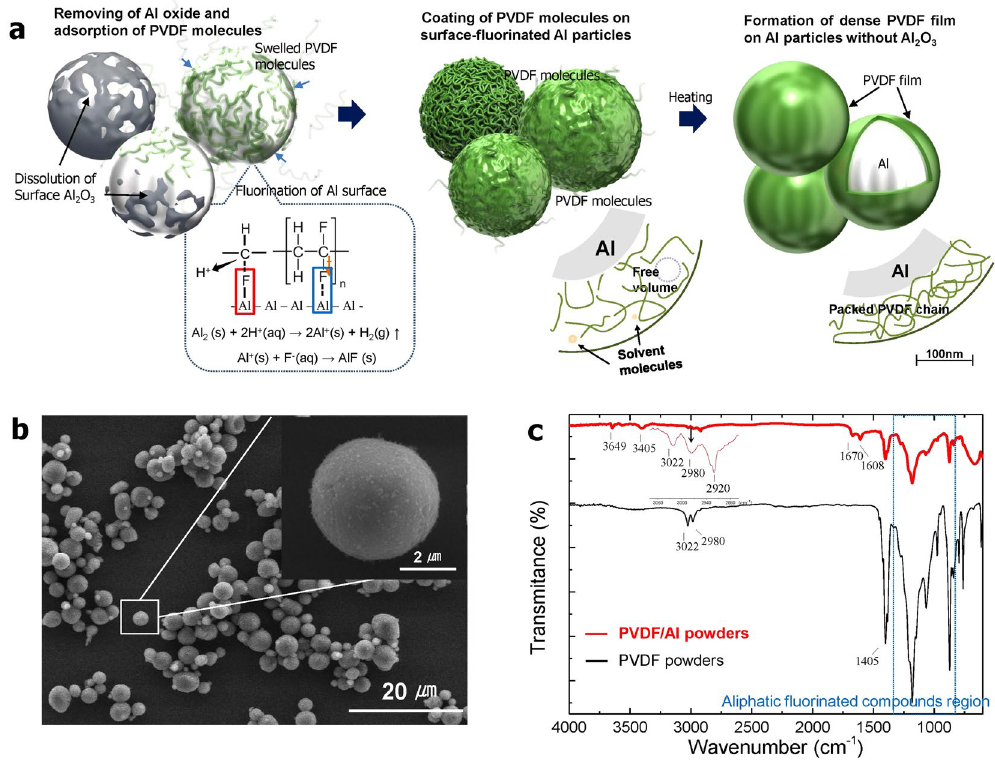
Figure 1. ( a ) Conceptual illustration showing the synthetic process of the PVDF-coated Al particles created via a fluoride reaction on the surface, ( b ) SEM images of the synthesized PVDF/Al powder, and ( c ) transmission FT-IR spectra of the PVDF/Al powder compared to the